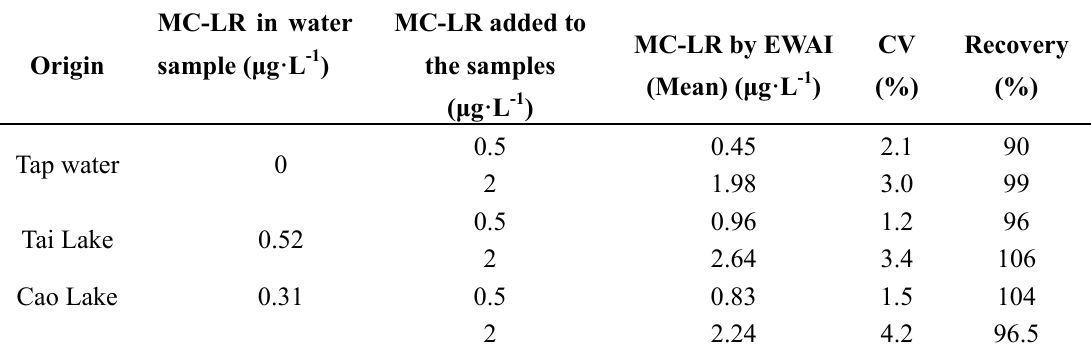
Table 1 Detection results of water